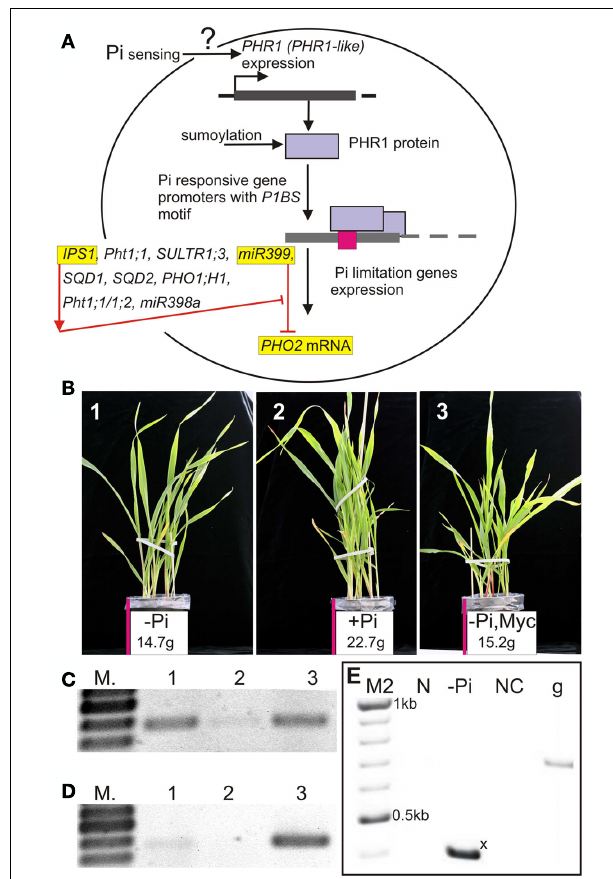
FIGURE 1 | (A) Schematic representation of the relation between Arabidopsis PHR1 or its orthologs and examples of Pi-responsive genes possessing PHR1 binding sites in their promoters. Arabidopsis : IPS1 and Pht1;1 genes have been described by Martin et al. (2000) and Muchhal et al. (1996), respectively; SULTR1;3 by Rouached et al. (2011); miR399 by Pant et al. (2009) and Kuo and Chiou (2011); SQD1 , SQD2 (involved in sulfolipid biosynthesis) by Franco-Zorrilla et al. (2004); PHO1;H1 (involved in Pi loading to the root xylem) by Stefanovic et al. (2007); barley Pht1;1/1;2 by Schünmann et al. (2004a); rice miR398a by Gu et al. (2010); (B) Barley grown without or with inorganic phosphate ( − Pi, + Pi) or without Pi but in the presence of mycorrhizal fungi ( − Pi Myc); (C) Barley HvPht1;1/1;2 expression in roots under different soil Pi and mycorrhiza conditions; (D) Barley HvPht1;8 expression in roots under different soil Pi and mycorrhiza conditions; (E) Arabidopsis pri-miR399a isoform expression under Pi sufficient growing conditions (N) and during Pi starvation ( − Pi).The short pri-microRNA399a isoform is marked with an x (see Figure 2B ). Lanes/pictures 1, 3 ( − Pi), lane/picture 2 ( + Pi), lane/picture 3 depicts roots colonized by the mycorrhizal fungus Glomus intraradices (28A). N, sufficient Pi conditions; − Pi, phosphate starvation; NC, negative control; g, genomic DNA positive control. M – GeneRuler 100bp DNA ladder, M2 –